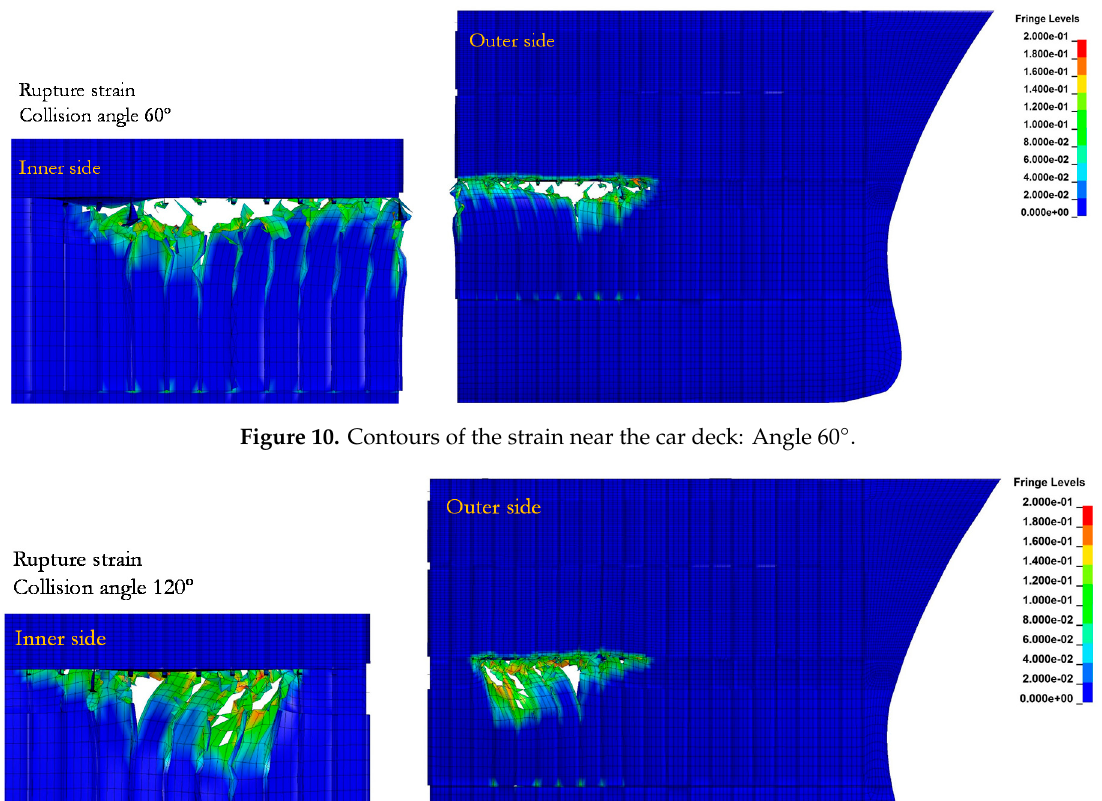
Figure 12. Contours of the strain near the car deck: Angle 90°. The observation of the damage pattern showed the most side frame on the oblique collision 120° was folded on the lower part while the upper part was crushed and pushed on the direction of the striking angle. Furthermore, the curved geometry on the fore-peak section made the crushing pattern of two oblique collisions different even though the angle size is the same according to the Cartesian diagram. In terms of the damage extent, the collision in 60° caused longer tear on the connection of the car deck and lower side shell influenced by deeper penetration. Moreover, the calculation of the penetration in the same depth predicted the damage length to be similar in terms of size. 5.5. Critical stress The stress in the current structural assessment was conducted to investigate the total number of members affected due to the car deck. According to the critical stress presented by von-Mises formulation in Figures 13–15, the affected members for the three cases were similar, and they include car deck (main target), girder, lower hull, upper hull, and middle deck. However, despite these similarities, high-stress intensity occurred quite extensive on the lower hull of the collision case 90°. It is, therefore, possible to come up with the estimation that the collision would continue, and the part covered by high stress would experience the earliest rupture, and the element removed in the calculation. It was also noted that the oblique collisions and T-collision have a quite distinct extent in terms of damage and stress with the former having the tendency to form an incision rather than deep- focus penetration produced by the latter on the struck vessel.